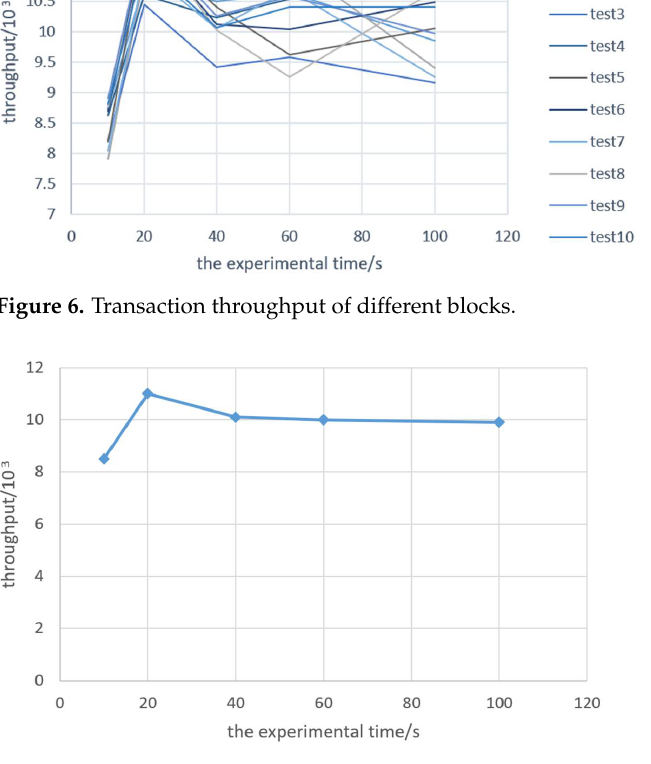
Figure 7. Throughput of the IIoT blockchain network.